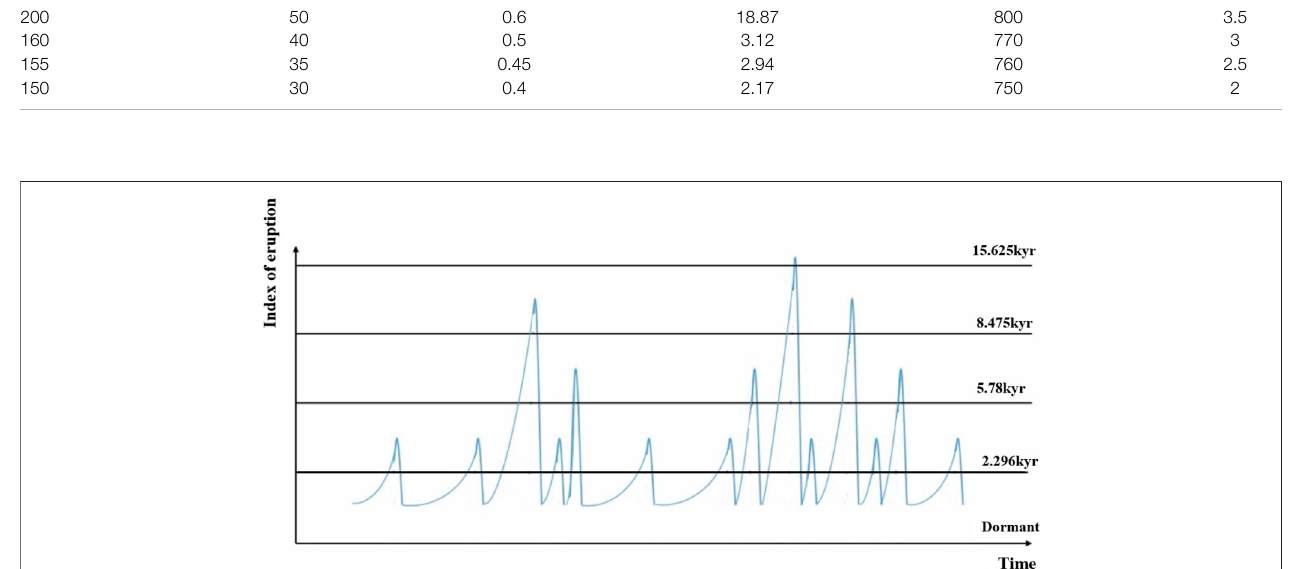
FIGURE 8 | Pulse pattern map of the volcanic eruption in the Yangjiaodong area of Lingshan